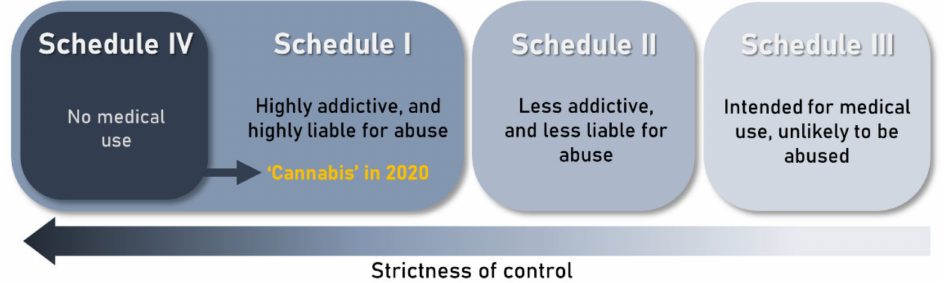
Figure 6. Narcotic drugs scheduling system as classified by the Single Convention on Narcotic Drugs of 1961. The Single Convention on Narcotic Drugs of 1961 classifies drugs and their prepa- rations in four schedules based on their dependence potential, abuse liability and therapeutic use- fulness [107]. Substances in schedule IV include the drugs in schedule I which have no therapeutic use. Following the recommendations of the World Health Organization, Cannabis was removed